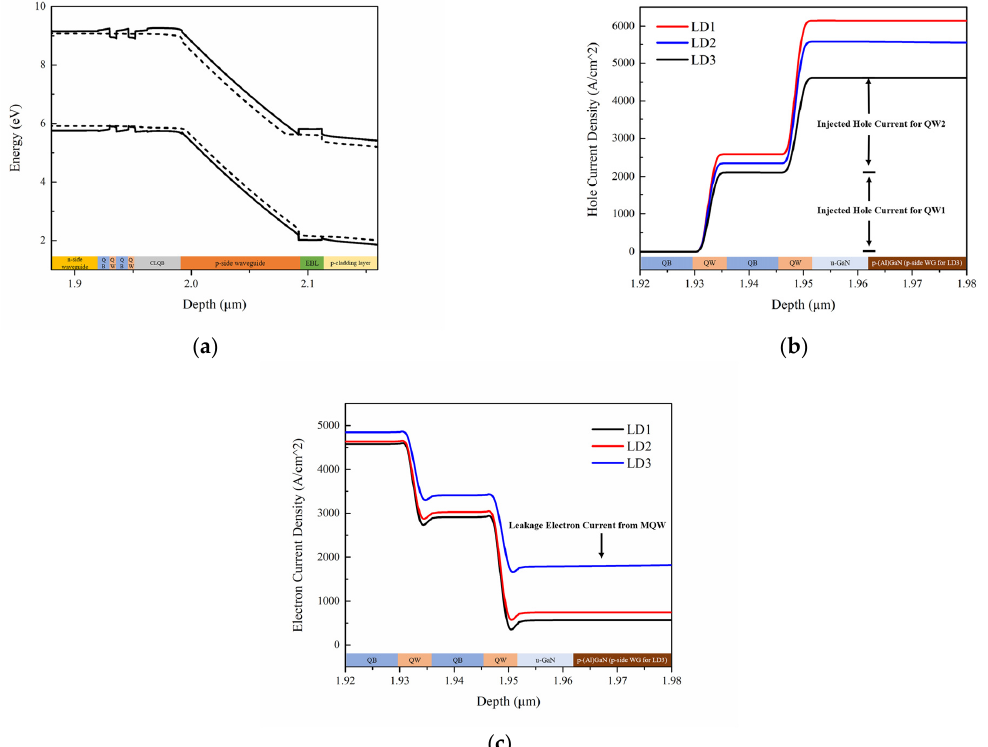
Figure 9. Band energy diagram of LD1 and hole/electron current density around MQW of three LDs. ( a ) Band energy diagram of LD1 at an injecting current of 120 mA where the dashed lines represent electron and hole Fermi levels; ( b ) Hole current distribution around the MQW regions at the vertical direction of three LDs; ( c ) Electron current distribution around the MQW regions at the vertical direction of three LDs.